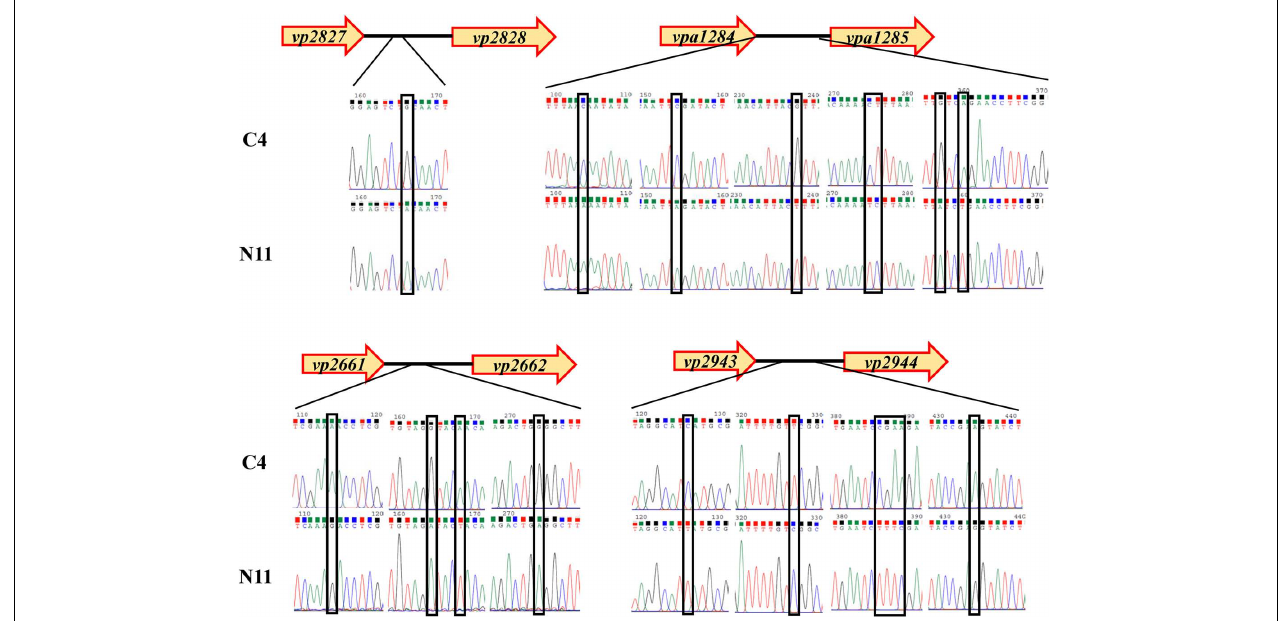
FIGURE 7 | Analysis of mutated nucleotides between the C4 strain and N11 strain by Sanger